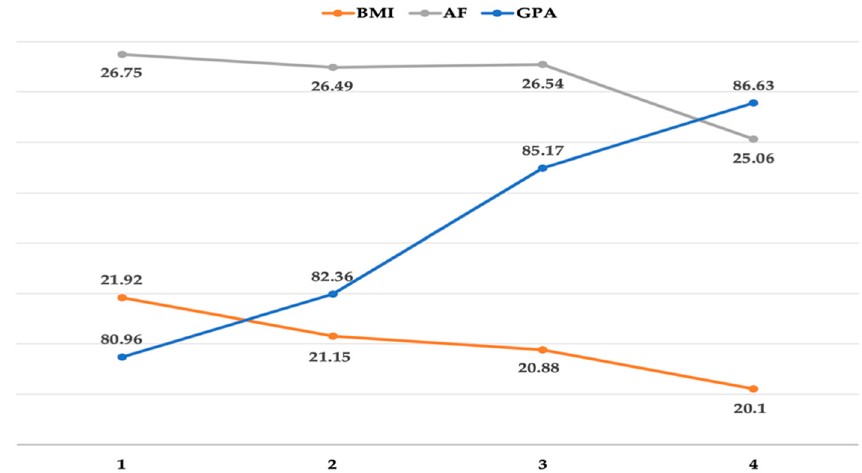
Figure 1. Changes of Aerobic Fitness (AF), Body Mass Index (BMI), and Grade Point Average (GPA) through the four years (Note: AF data were divided by 100 in order to fit all three variables in the same figure).